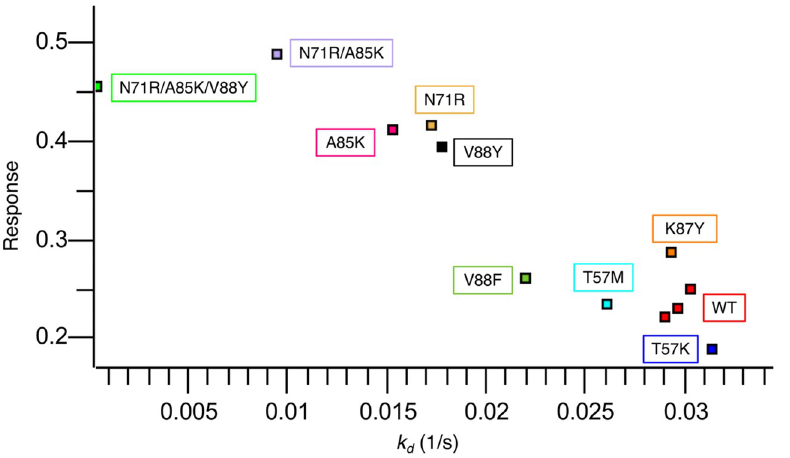
Fig 8. Single-concentration experimental screening of c-Raf-RBD variants binding to KRas using BLI. c-Raf-RBD variants at 250 nM were allowed to associate with KRas GppNHp immobilized on a Ni-NTA OctetRed96 BLI tip for 180 s and then dissociation was measured and fitted for 120 s. All dissociation fits were performed in a local 1:1 model and showed strong agreement with the data, every fit having greater than a R 2 of 0.99 and a χ 2 lower than 0.01. The fitted dissociation rate constant ( k d (1/s)) is plotted versus the response rate for each variant. Each point is labeled with its corresponding variant boxed in the corresponding color. A triplicate repeat was performed for the c-Raf-RBD wild- type (WT) variant (red). Variants fall into three groups: variants similar to WT (T57K in blue, T57M in cyan, WT in red, K87Y in orange, and V88F in forest green), variants better than WT (A85K in pink, N71R in sand, and V88Y in black), and variants with a response more than twice as large as WT (RK in purple and RKY in green). These results were used as a screen with the most promising variants being studied further by full titration BLI experiments (see Fig 10). The corresponding BLI response curves for this experiment are presented in S1